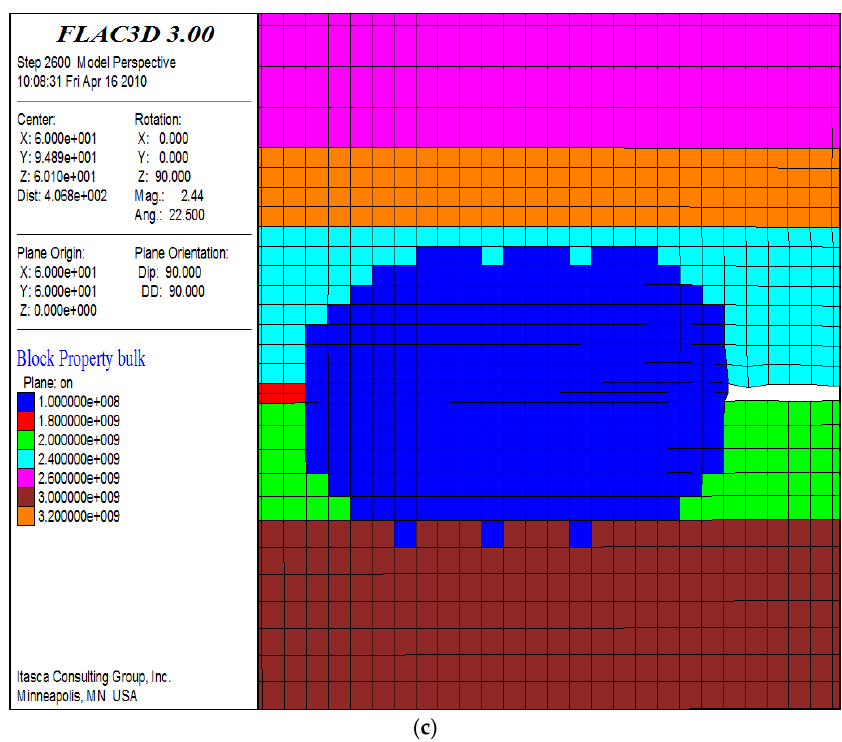
Figure 14. Simulation of the water-affected area for different number of boreholes: ( a ) one, ( b ) two and ( c ) three.